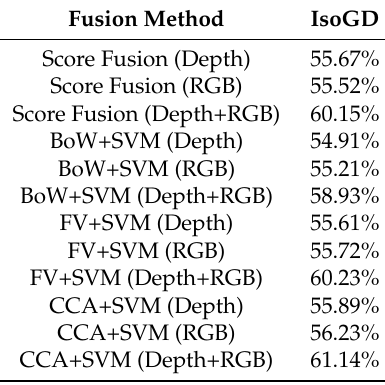
Table 5. Performance comparison on IsoGD with different fusion